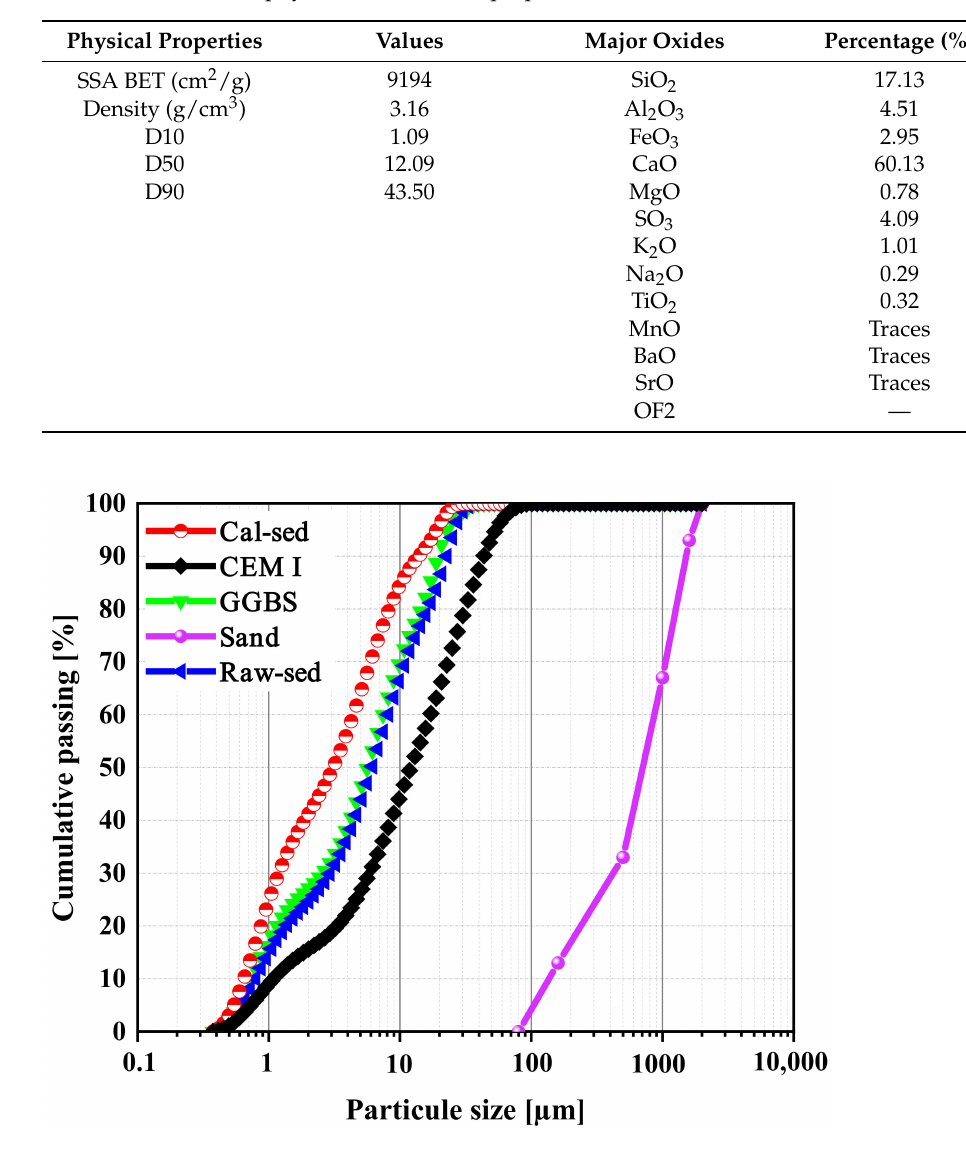
Figure 1. Particle size distribution of cement, GGBS, sand, and other supplementary